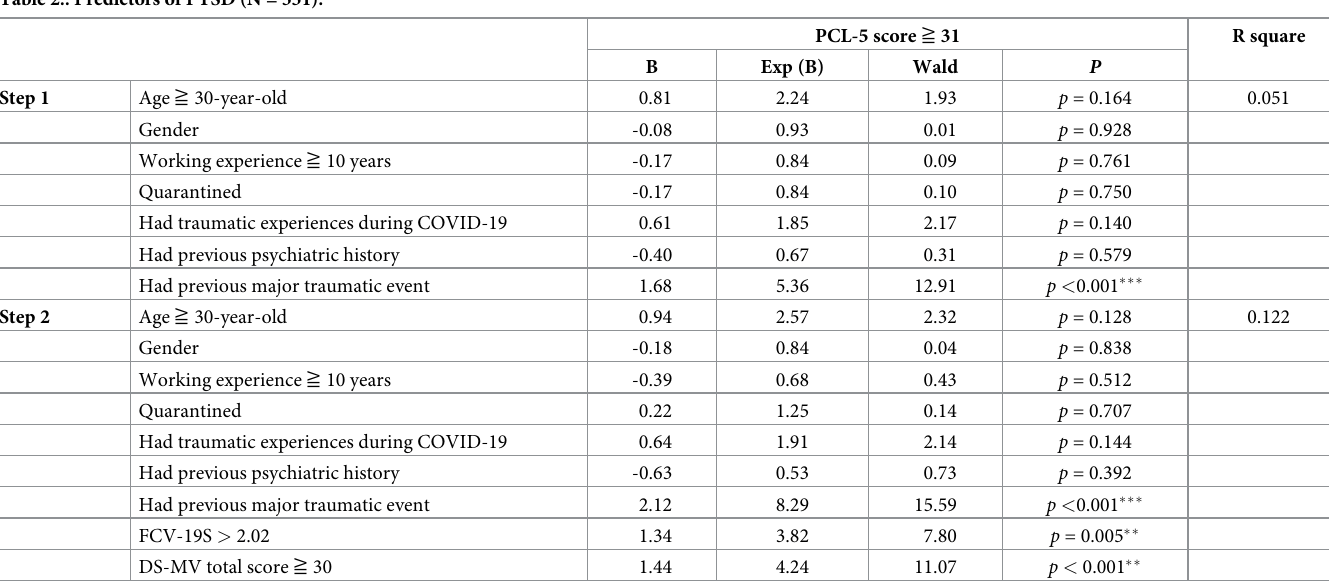
Table 2.. Predictors of PTSD (N = 351).